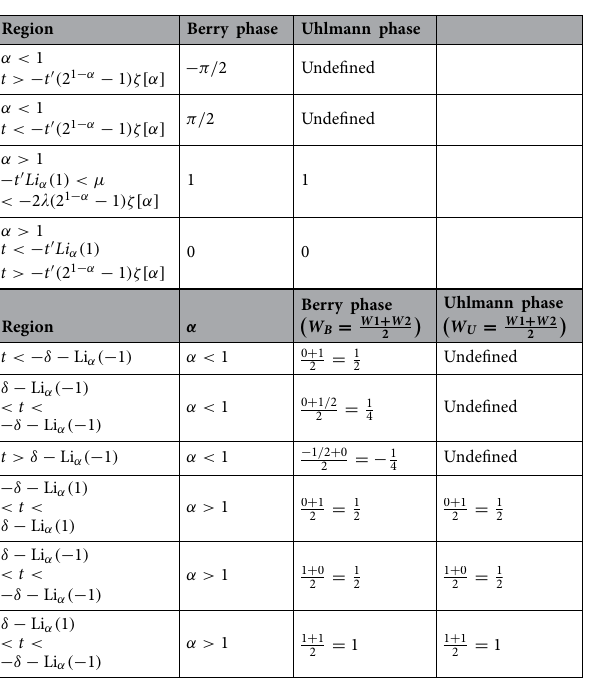
Table 3. A comparison of different pure and mixed state geometric phases of long-range SSH chain for infinite neighbors ( r ). The Berry phase and Uhlmann phase are calculated through Eqs. (4) and (10) → ∞ respectively. Here the geometric phases are quantized in the units of π with t ′ represents the Hermitian and non-Hermitian SSH chains